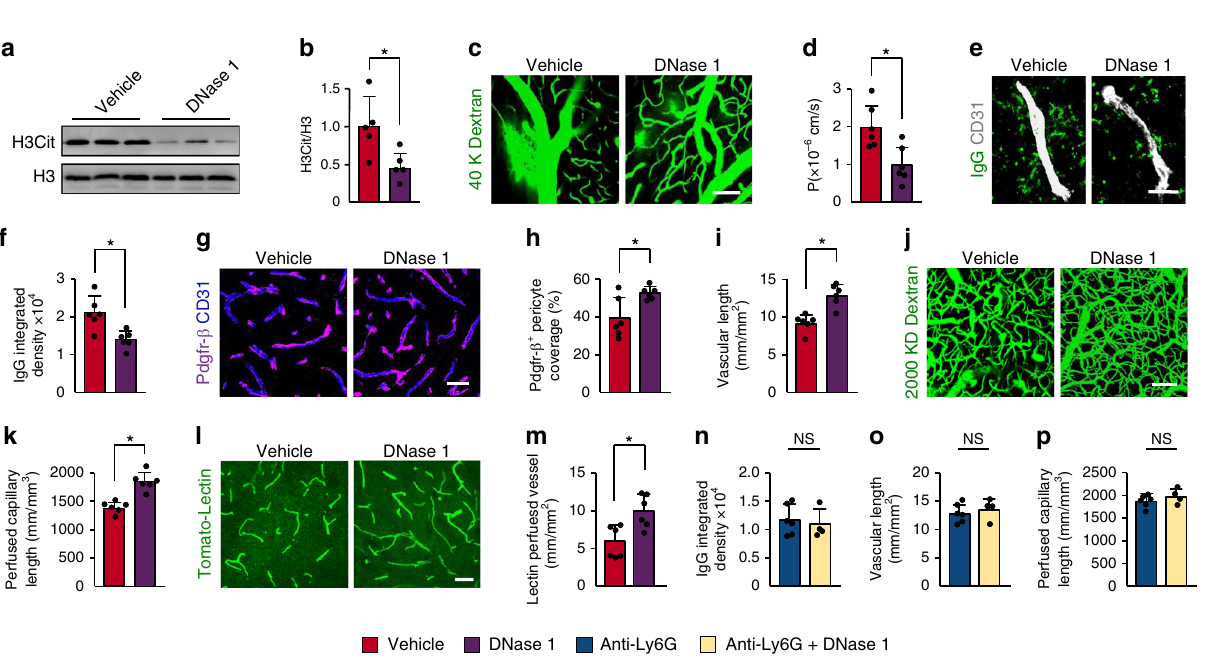
Fig. 4 DNase 1 reduces BBB breakdown and increases neovascularization after stroke. a , b Representative immunoblots ( a ) and quanti fi cation of H3Cit levels ( b ) in the peri-infarct cortex at 3 days in mice treated with vehicle or DNase 1 ( n = 5), unpaired two-tailed Student ’ s t -test was applied with * P = 0.0228. c Representative images of multiphoton microscopy of intravenously injected FITC-dextran (MW = 40,000 Da; green) leakage in cortical vessels at 14 days after stroke in mice treated with vehicle or DNase 1. Bar = 100 μ m. d Quanti fi cation of the permeability (P) product of FITC-dextran for each group ( n = 6 biologically independent animals), unpaired two-tailed Student ’ s t -test was applied with * P = 0.0083. e , f Representative images of IgG deposits and CD31-positive microvessels ( e ) at 14 days after stroke in mice treated with vehicle or DNase 1, and quanti fi cation of extravascular IgG deposits ( f ) for each group ( n = 6 biologically independent animals), unpaired two-tailed Student ’ s t -test was applied with * P = 0.0052. Bar = 20 μ m. g , h Representative images ( g ) and quantitative analysis ( h ) of Pdgfr- β -positive pericyte coverage on CD31-positive brain capillaries at 14 days ( n = 6 biologically independent animals), unpaired two-tailed Student ’ s t -test was applied with * P = 0.0175. Bar = 40 μ m. i Quanti fi cation of microvascular length in the peri-infarct cortex at 14 days ( n = 6 biologically independent animals), unpaired two-tailed Student ’ s t -test was applied with * P = 0.0007. j , k In-vivo multiphoton microscopic images of perfused cortical capillaries with intravenously injected FITC-dextran (MW = 2000,000 Da) ( j ) and quanti fi cation of perfused capillary length ( k ) at 14 days ( n = 6 biologically independent animals), unpaired two-tailed Student ’ s t -test was applied with * P = 0.0003. Bar = 100 μ m. l , m Representative images of tomato-lectin perfused vessels ( l ) and quanti fi cation of lectin perfused vessels ( m ) at 14 days ( n = 6), Mann – Whitney test was applied with * P = 0.0152). Bar = 40 μ m. n – p Quanti fi cation of extravascular IgG deposits ( n ), microvascular length ( o ), and perfused capillary length ( p ) in the peri-infarct cortex at 14 days ( n = 6 for Anti-Ly6G, n = 4 for Anti-Ly6G + DNase 1), unpaired two-tailed Student ’ s t -test was applied with P = 0.6496 ( n ), P = 0.5222 ( o ), P = 0.2844 ( p ). Data are presented as mean ± SD. Source data underlying graph a , b , d , f , h , i , k , and m – p are provided as a Source Data fi